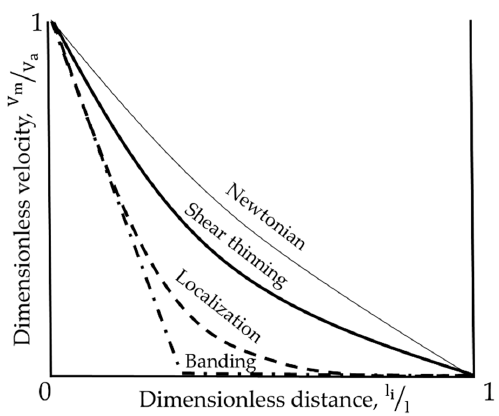
Figure 2. Schematic velocity distributions observed for fluids in a wide-gap Couette geometry; l i is the distance from the inner cylinder wall, l is total length of the gap, V m is the measured velocity of fluid in the gap, V a is the applied rotational velocity.